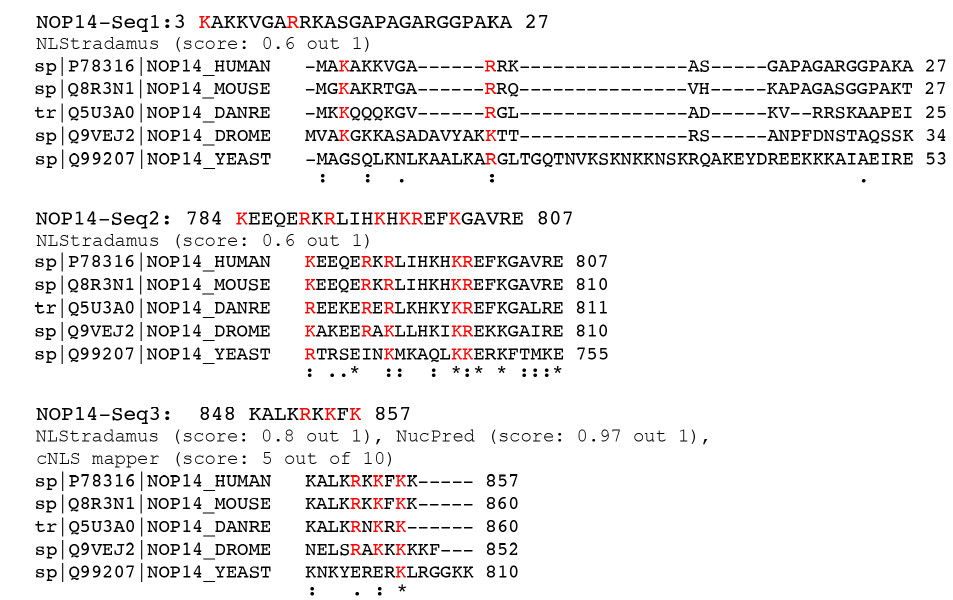
Figure 7. Protein sequence alignments of the putative NLSs of NOP14 from five different organisms. The conserved basic residues are in red. The sequences are from humans, mouse, zebrafish ( Danre ), fruit fly ( Drome ), and yeast. An asterisk (*) indicates positions that have single, fully conserved residues in all five sequences; a colon (:) indicates conserved amino acids of strongly similar properties; and a period (.) indicates conservation between amino acids of weakly similar properties.